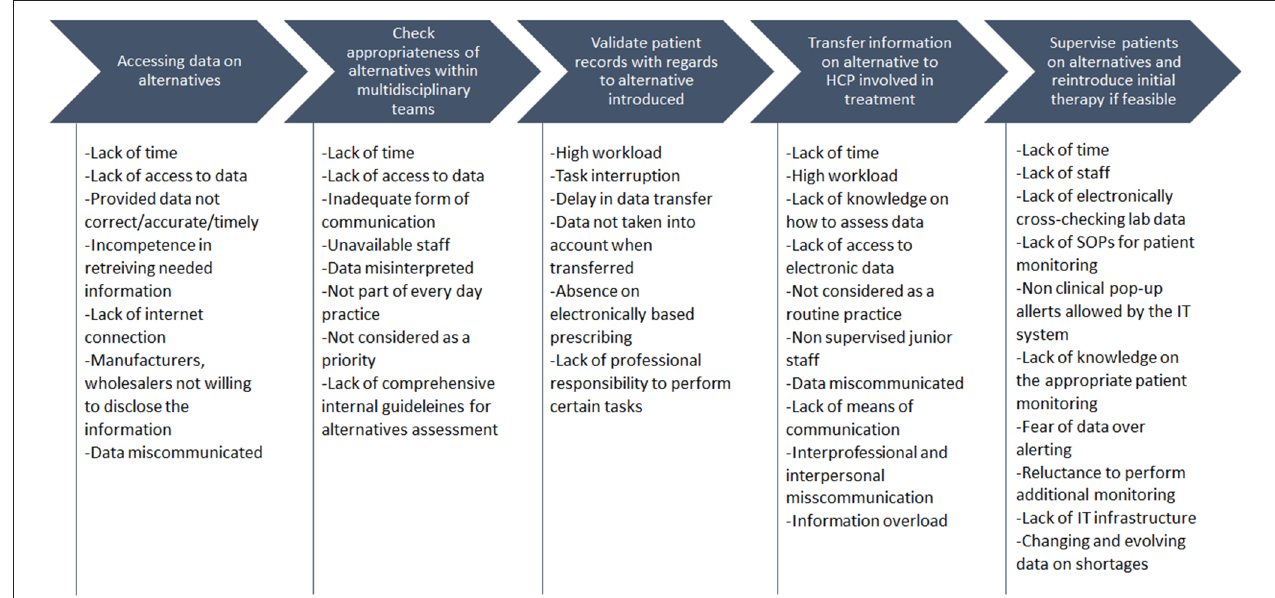
FIGURE 2 | Major failure mode causes related to key sub-processes in antibiotic